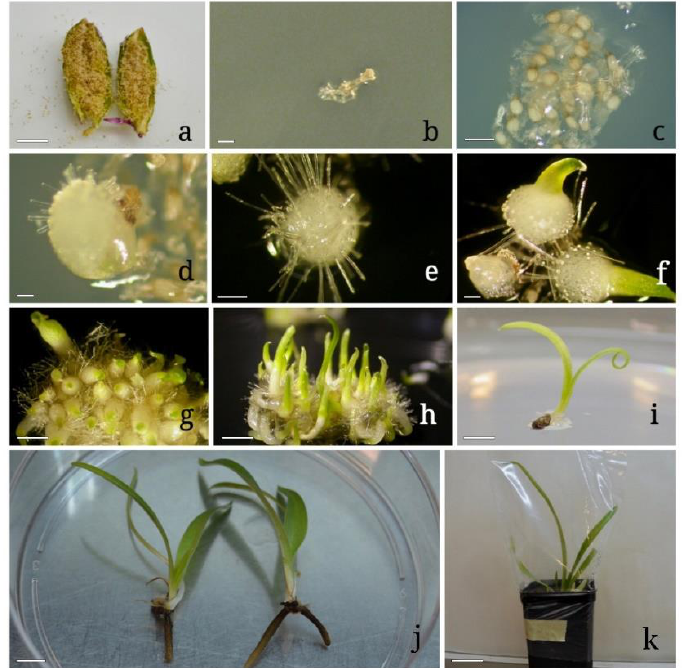
Figure 2. In vitro asymbiotic germination of Anacamptis longicornu : ( a ) opened capsule of Anacamptis longicornu ; ( b ) stage 0 ‘’no germination’’; ( c ) stage 1 ‘’pre-germination’’; ( d ) stage 2 ‘’germination’’; ( e ) stage 3 ‘’protocorms’’; ( f ) stage 4 ‘’appearance of protomeristem’’; ( g ) stage 5 ‘’emergence of first leaf’’; ( h ) stage 6 ‘’elongation of first leaf’’; ( i ) stage 7 ‘’emergence of second leaf’’; ( j ) emergence of first true root; ( k ) acclimatization. Bars: 10 mm ( a , h – k ); 2 mm ( b – d ); 3 mm ( e , f ); 0.5 mm ( g ).